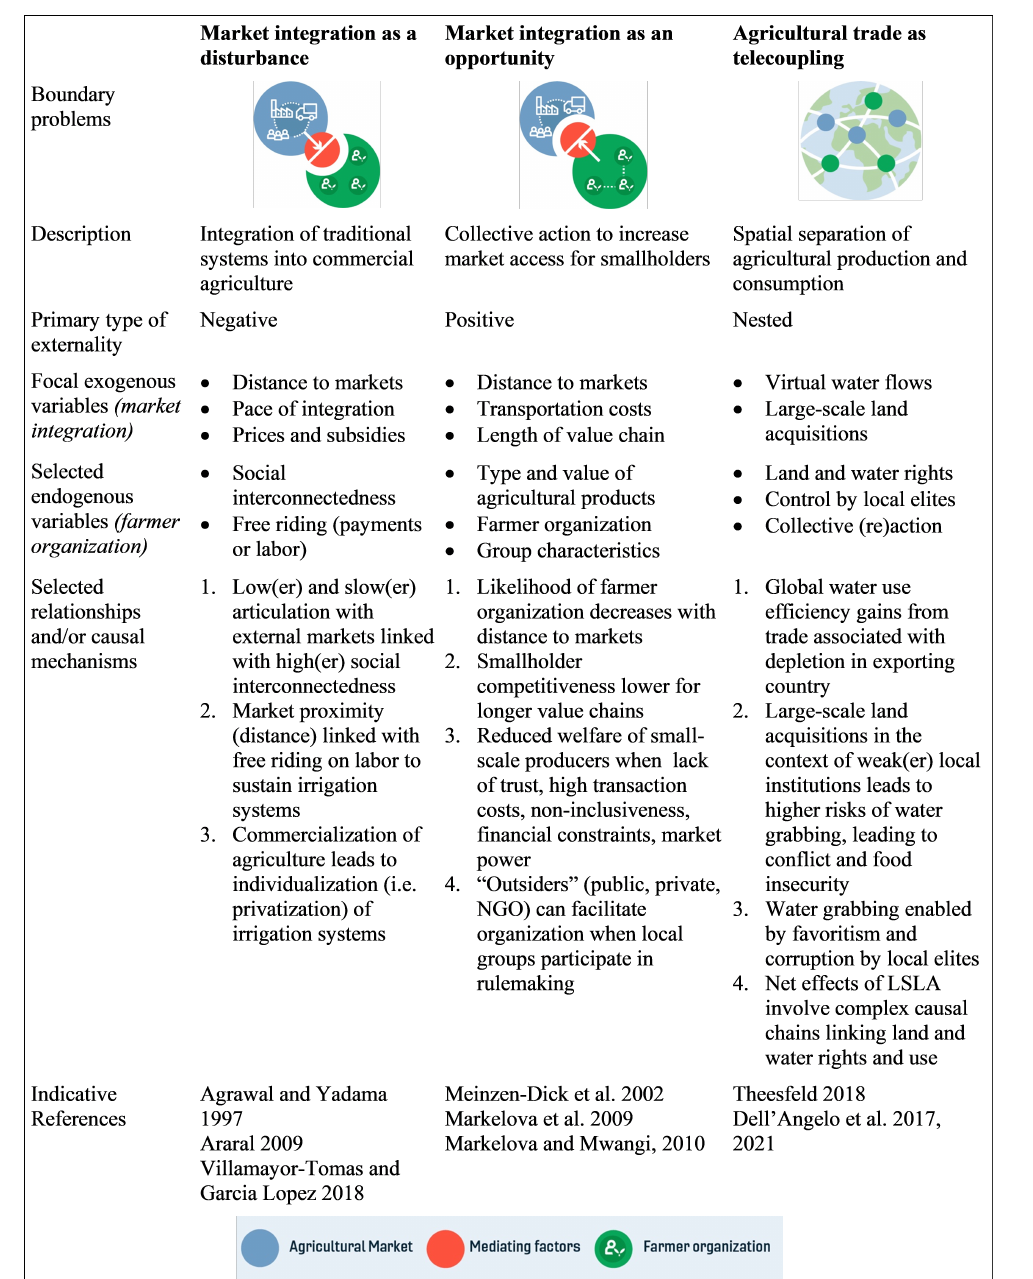
Fig. 1. Conceptual perspectives on agricultural markets and adaptive water